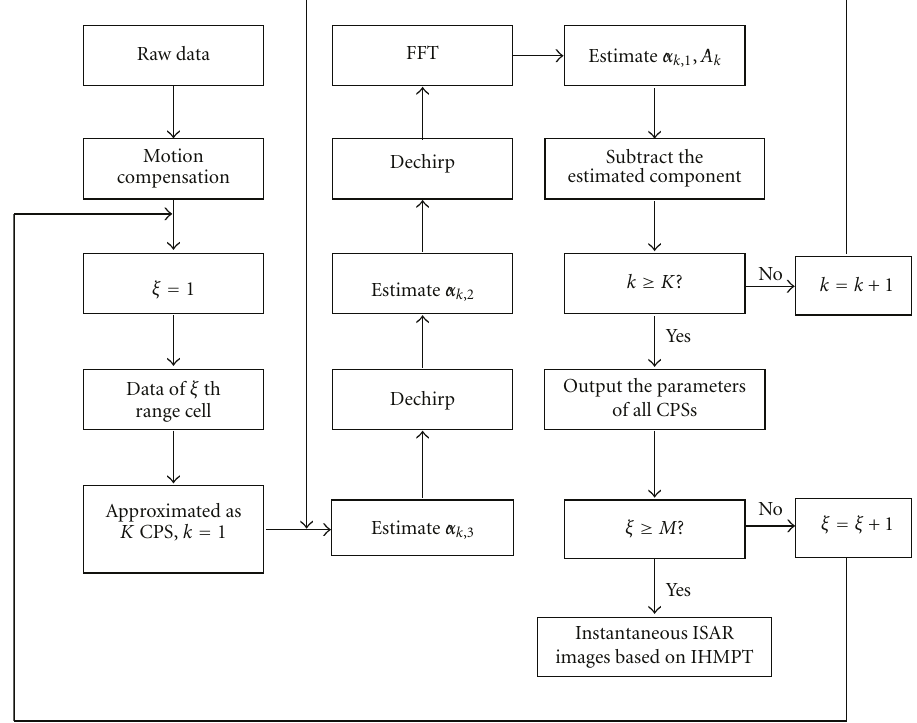
Figure 3: Flow chart of ISAR imaging based on IHMPT algorithm.